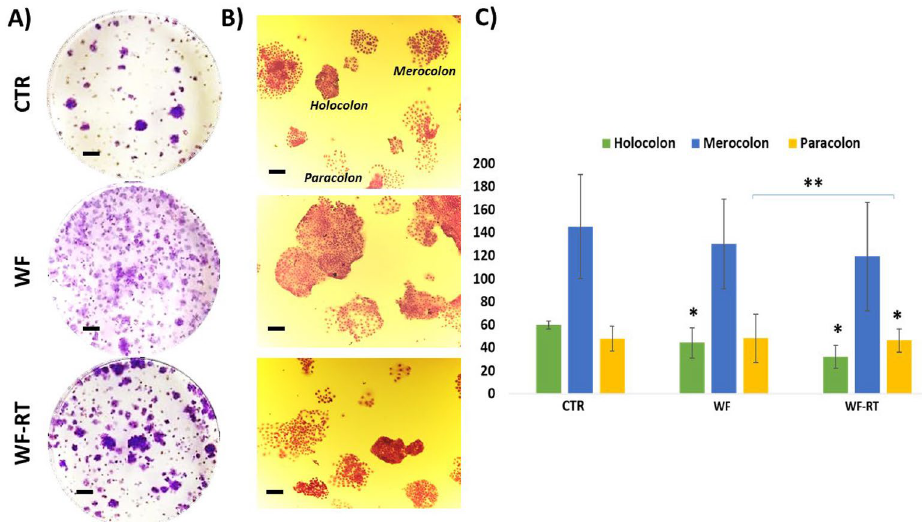
Figure 4. Clonogenic survival assays following treatment with WFs. MCF7 cells were treated with WFs from different groups. After 48 h, the compounds were removed, and cells were seeded at a density of 1000 cells for MCF7 on 35 mm plates. After 7 days of incubation, the cells were stained with crystal violet, and the stained plates were scanned. ( A ) Represents the images of colony density in a 6-well plate. Original magnification: ×40. Scale bars: 50 µm. ( B ) Images of colony shape. Original magnification: ×40. Scale bars: 100 µm. ( C ) Quantitative analysis based on colony shapes. Significant value from comparing WF and WF-RT groups with CTR groups has shown with *P < 0.05 and **P < 0.01.